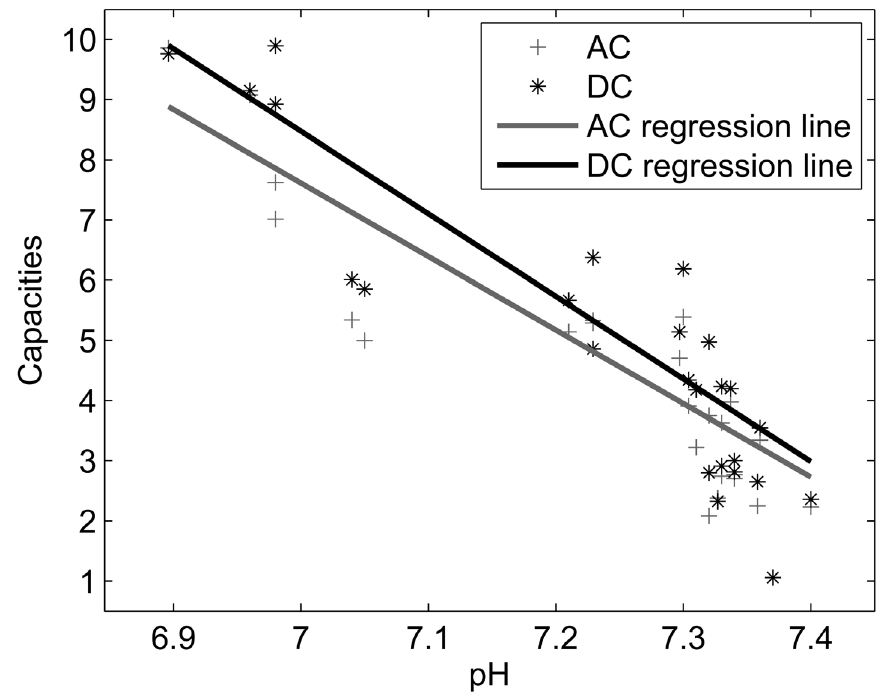
Figure 4. Relation between AC and DC with pH for T =4 (entire fRR series) . doi:10.1371/journal.pone.0104193.g004 PLOS ONE |